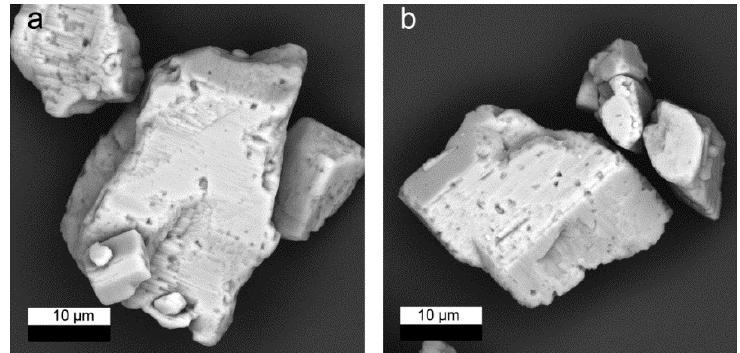
Figure 6. SEM micrographs of SL barite at the end of experiments with 1.0 mol/kg NaCl at 90 °C, ( a ) S/L = 5 g/kg, ( b ) 0.5 g/kg.